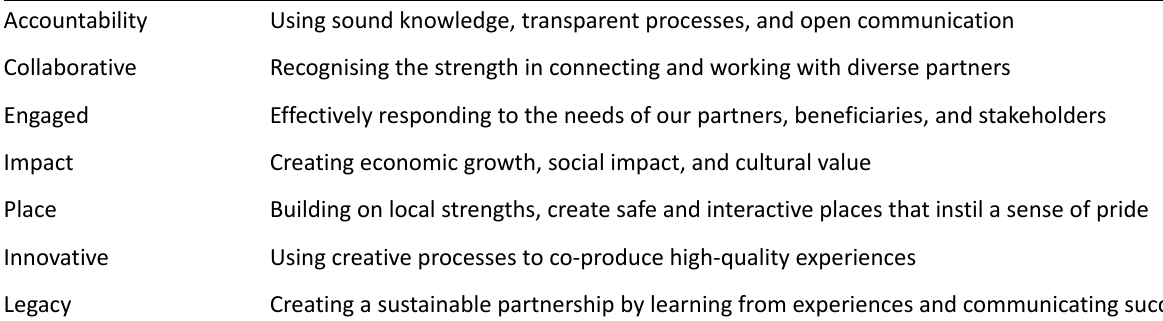
Table 3. Co‐created